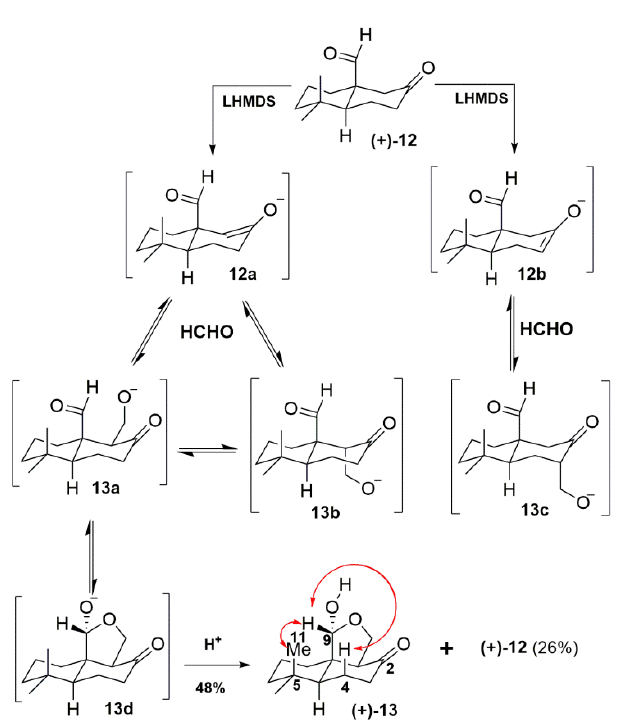
Figure 5. Proposed kinetic-controlled aldol addition of (+)- 12 with monomeric formaldehyde.